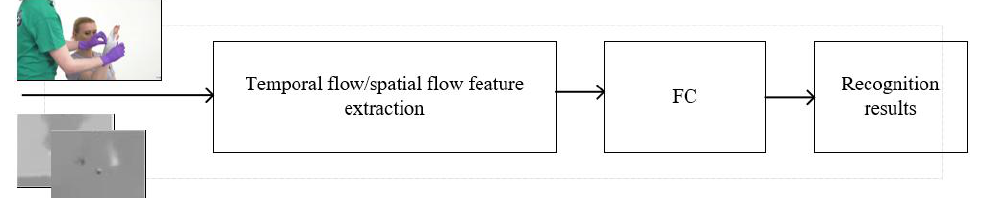
Figure 6. Early-stage fusion